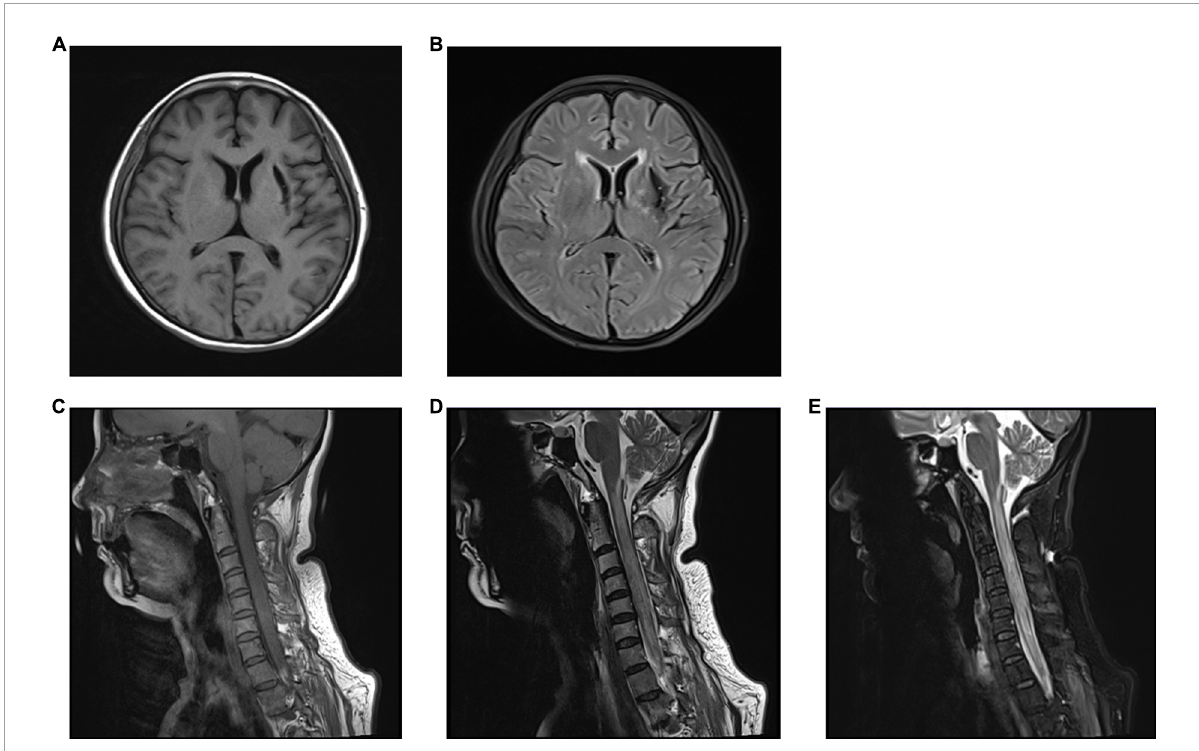
FIGURE2 The brain and cervical spine magnetic resonance imaging (MRI) performed at 2 weeks. (A,B) Brain MRI showed the left basal ganglia-insular softening foci in T1 (A) and T2 (B) weighted image. (C–E) Cervical spine MRI showed diffuse hyperintense signal in the cervical cord in T2-weighted image (D) and fluid-attenuated inversion recovery (FLAIR) images (E) , and normal findings were observed in T1-weighted image (C)